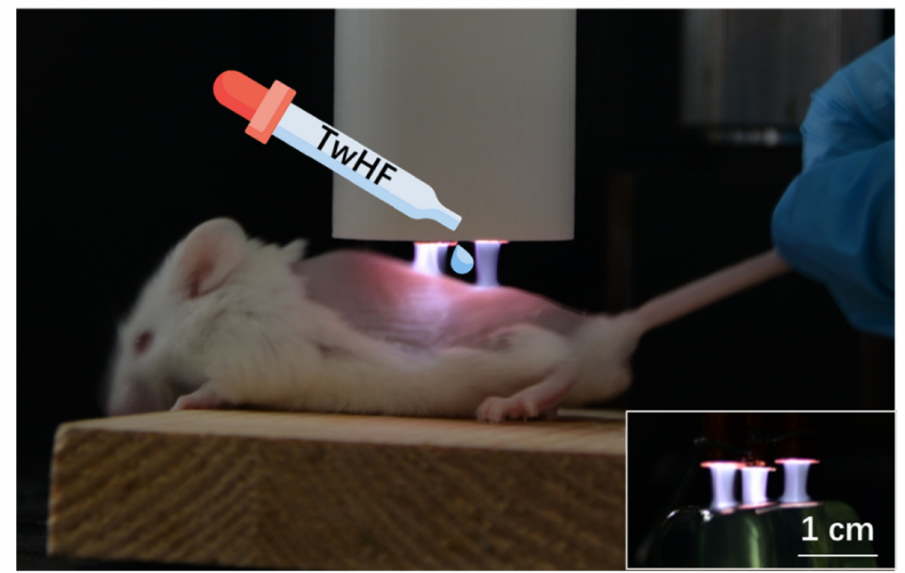
Figure 1. Photo of the combined treatment of imiquimod-induced psoriasiform dermatitis in mice by the LTP jet array and with TwHF.